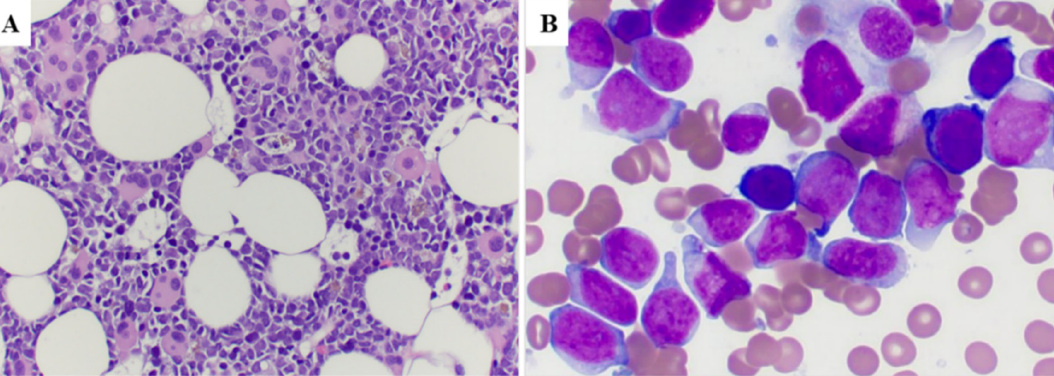
Figure 2. Bone marrow morphology in a representative case (case #8). ( A ) Bone marrow core biopsy shows a hypercellular marrow with increased immature cells as well as many dysplastic megakaryocytes with small hypolobated or separated nuclear lobes (100×); ( B ) Bone marrow smear shows increased blasts that are large with dispersed chromatin and distinct nucleoli (500×).